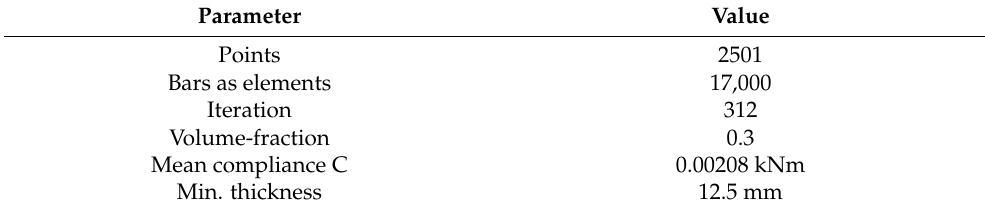
Figure 15. ( a ) tetrahedron-surface-mesh of the generated geometry ( b ) quad-mesh of the geometry ( c ) vertical section through the node, ( d ) horizontal section through the node. The calculation was performed with the additional condition of minimum thickness of 12.5 mm.